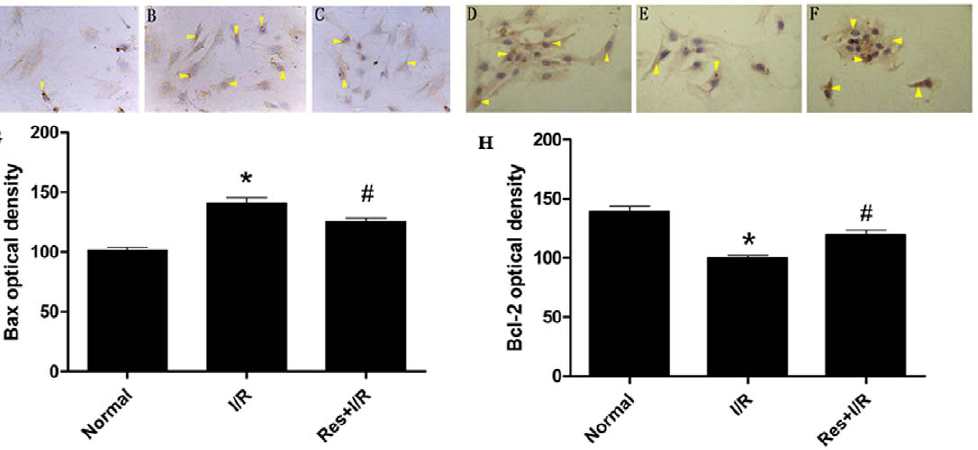
Figure 4. The expression of Bax and Bcl-2 detected by immunohistochemistry. The expression of Bax and Bcl-2 were shown and arrows refer to them. (A)(D)In normal condition, Bax and Bcl-2 were expressed in cardiomyocytes. (B)(E) I/R injury promoted Bax expression and suppressed Bcl-2 expression. (C)(F)On the contrary, Res suppressed Bax expression and promoted Bcl-2 expression. (G) The statistical data of Bax optical density. (H) The statistical data of Bcl-2 optical density. * P , 0.01 versus normal group, # P , 0.01 versus I/R group. Values are the means 6 SD, n=10 in each group. doi:10.1371/journal.pone.0051223.g004 PLOS ONE |